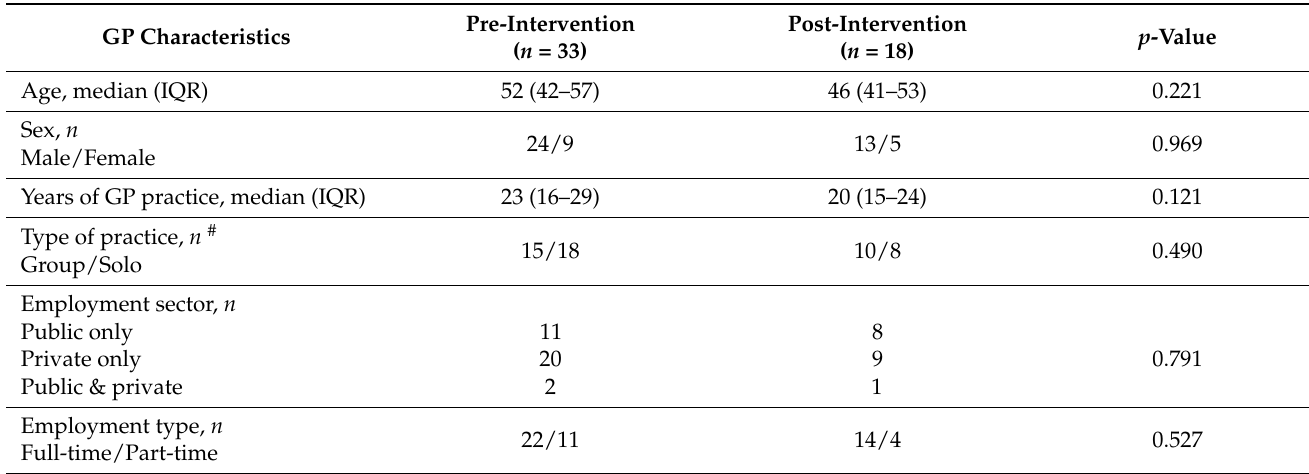
Table 1. Comparison of general practitioners’ characteristics: pre- versus